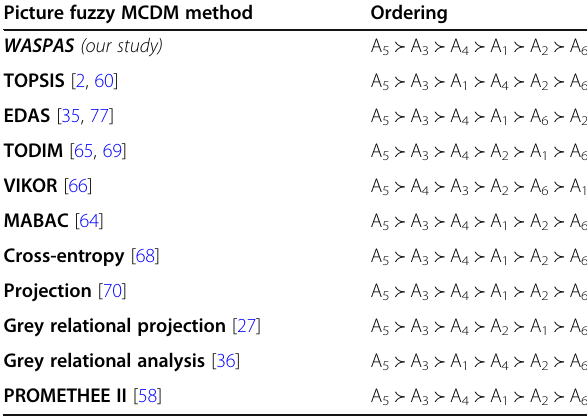
Table 4 The comparative analysis of the picture fuzzy MCDM methods Picture fuzzy MCDM